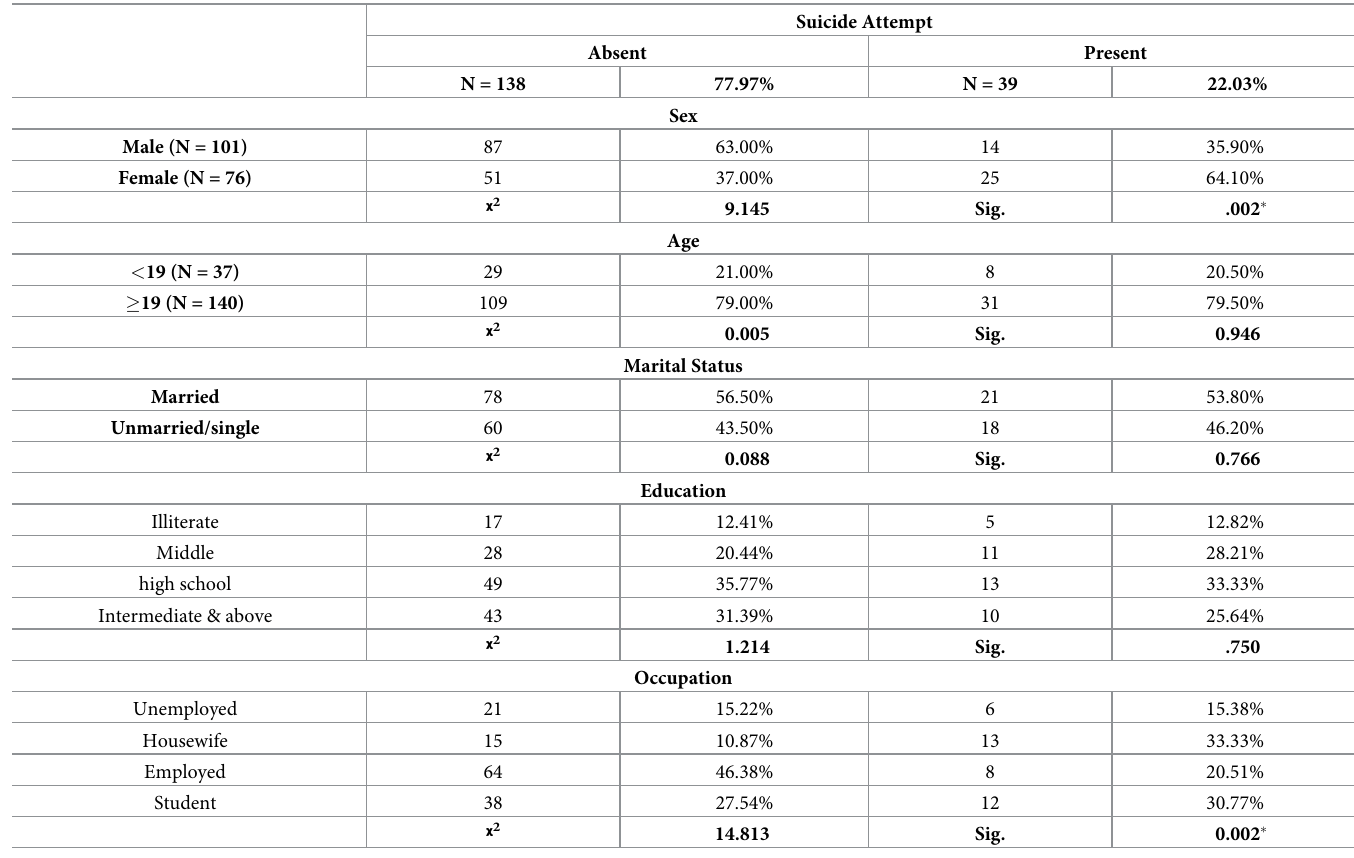
Table 1. Demographic characteristics of the Idu Mishmi suicide attempters (Univariate chi sqaure ( ᵡ 2 )Test